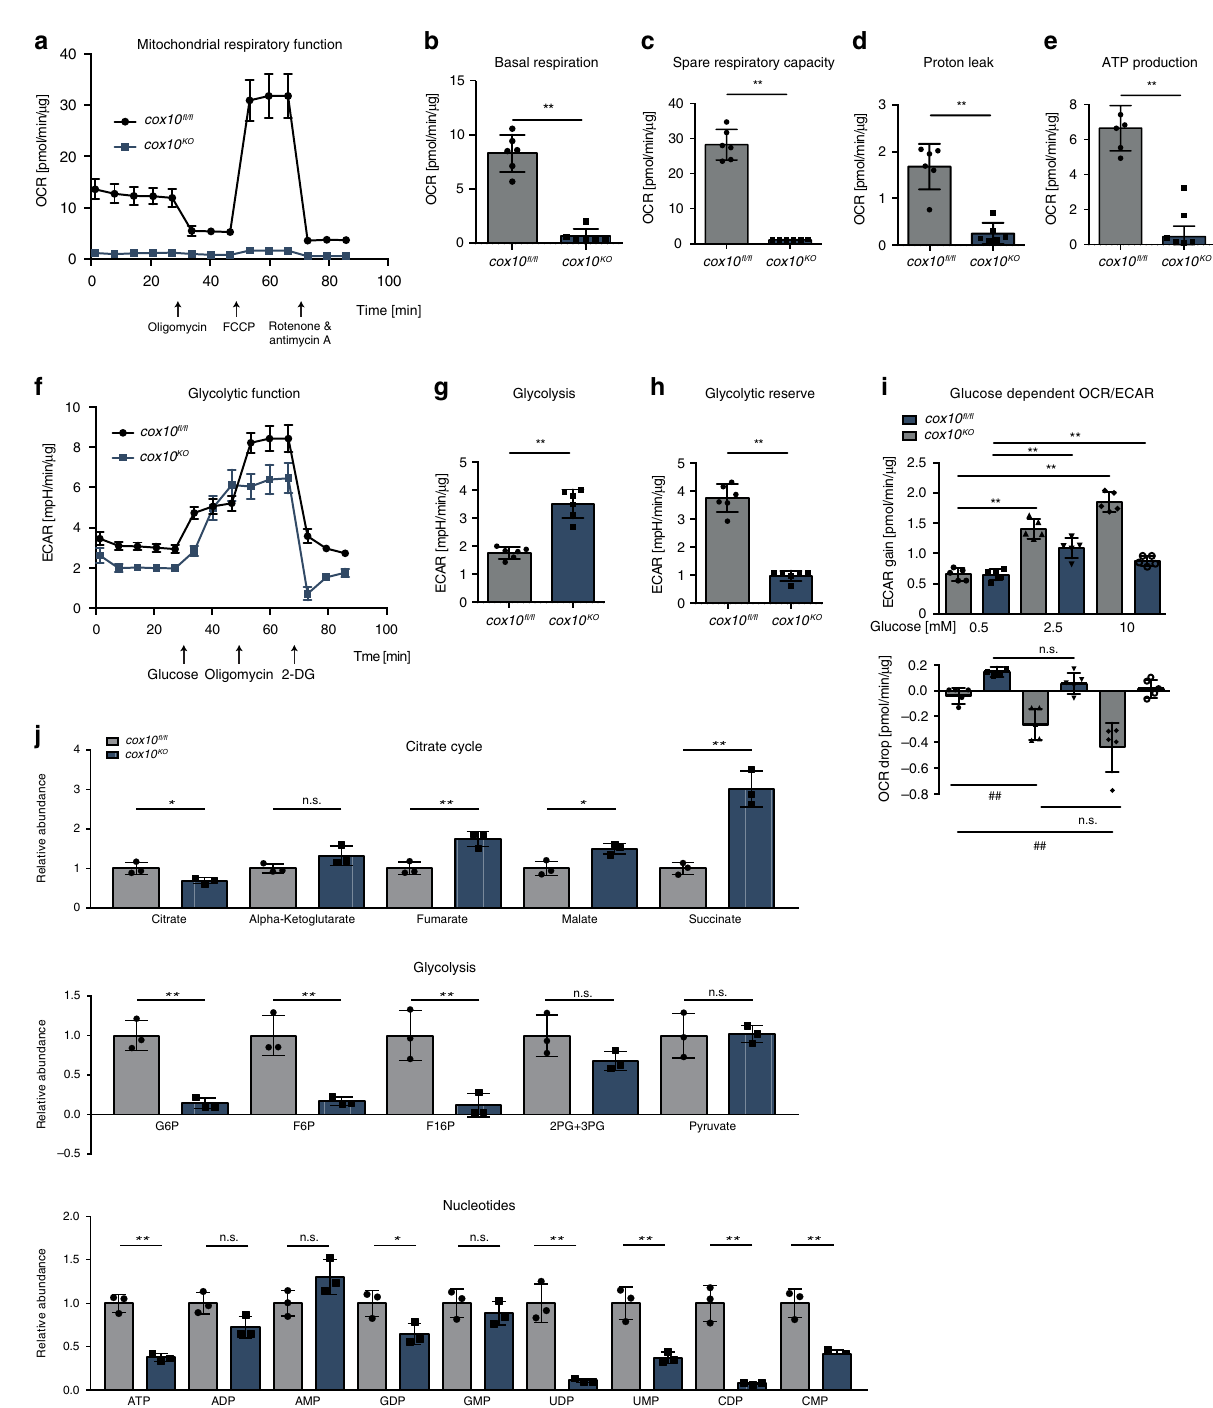
Fig. 2 Loss of endothelial cox10 changes EC metabolic phenotype. a Oxygen consumption rates (OCR) of COX pro fi cient cox10 fl / fl control primary ECs vs. COX-de fi cient cox10 KO ECs before and after sequential injection of oligomycin, FCCP and a mixture of rotenone/antimycin A by a Seahorse XF96 analyser. b – e Corresponding calculated parameters of mitochondrial respiration. f Extracellular acidi fi cation rate (ECAR) of cox10 fl / fl vs. cox10 KO ECs after sequential injection of glucose, oligomycin and 2-DG (2-deoxy-D-glucose). g , h corresponding calculated parameters expressing glycolytic capacity of ECs. i Calculation of drop in OCR or gain in ECAR of isolated murine ECs ( cox10 fl / fl control primary ECs vs. COX-de fi cient cox10 KO ECs) in response to different glucose concentrations. j Metabolomic analysis of pathway intermediates, grouped into citrate cycle, glycolysis and nucleotides, normalised to cox10 fl / fl controls. Data are presented as mean ± SD. Individual data points in ( a ) – ( j ) represent technical replicates within a representative experiment, sample size: a – h n = 6, i n = 5, j n = 3. Exact p -values (unpaired students t -test, two-tailed): b , c , d , e , g , h <0.0001; i gain from bottom to top: **<0.0001, ** = 0.0024, ** = 0.0009, ** = 0.0034. Drop from bottom to top: ##: 0.0022, n.s.: 0.1202, ##: 0.0066, n.s.: 0.0515. j Citrate cycle from left to right: 0.0339, 0.1097, 0.0068, 0.0191, 0.0019; glycolysis from left to right: 0.0019, 0.0052, 0.0116, 0.1247, 0.9148. Nucleotides from left to right: 0.0006, 0.0534, 0.1033, 0.0348, 0.3952, 0.0024, 0.0055, 0.0015,